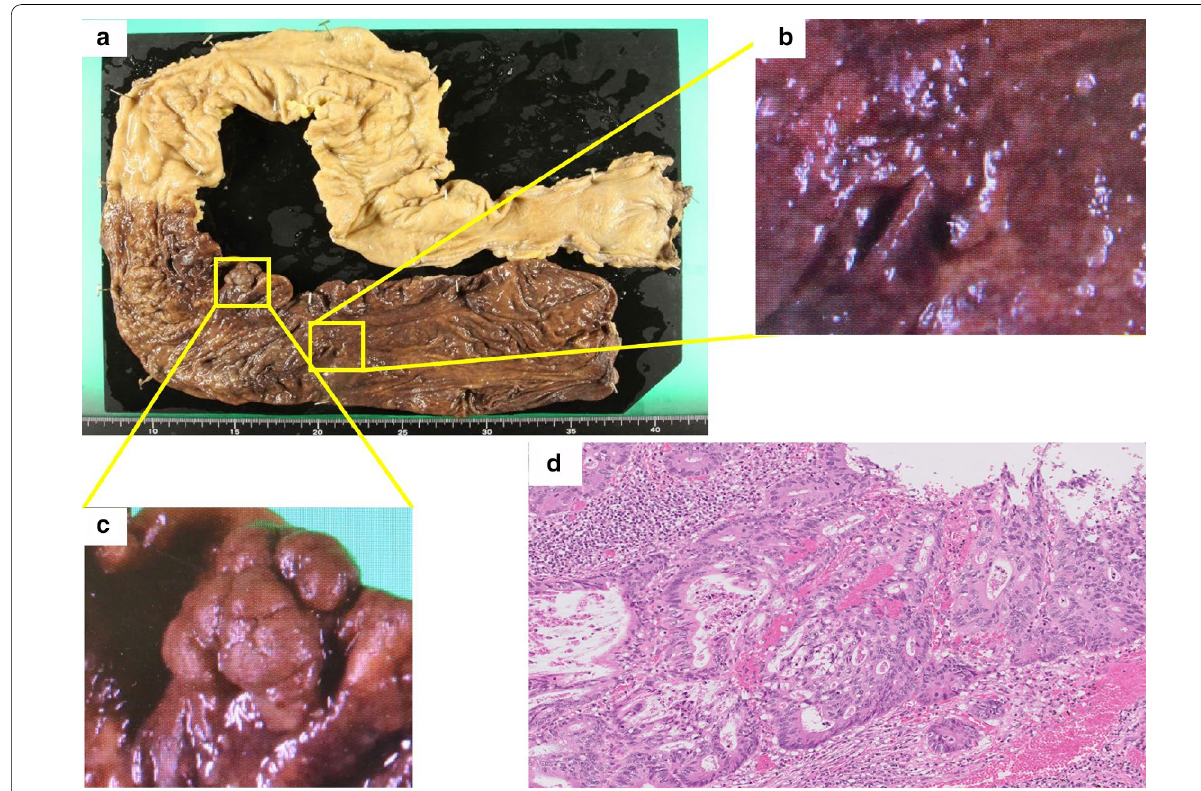
Fig. 3 a Macroscopic findings of the resected lesion. Severe inflammation was observed in the whole colonic mucosa and the right colon was brown because of mucosal hemorrhages. b Slightly elevated lesion in the ascending colon. c Slightly elevated lesion in the transverse colon. d Histological examination of the tumor revealed well-differentiated to moderately differentiated adenocarcinoma in the mucosa of the ascending colon (hematoxylin and eosin staining; magnification, ×